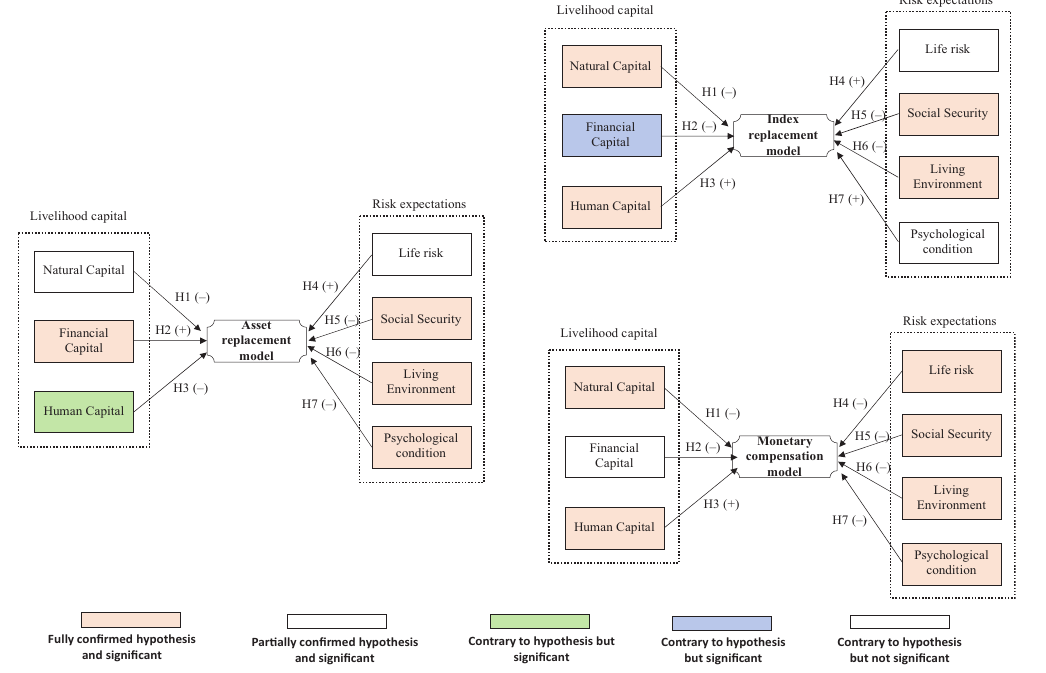
Figure 3. Empirical result for three individual